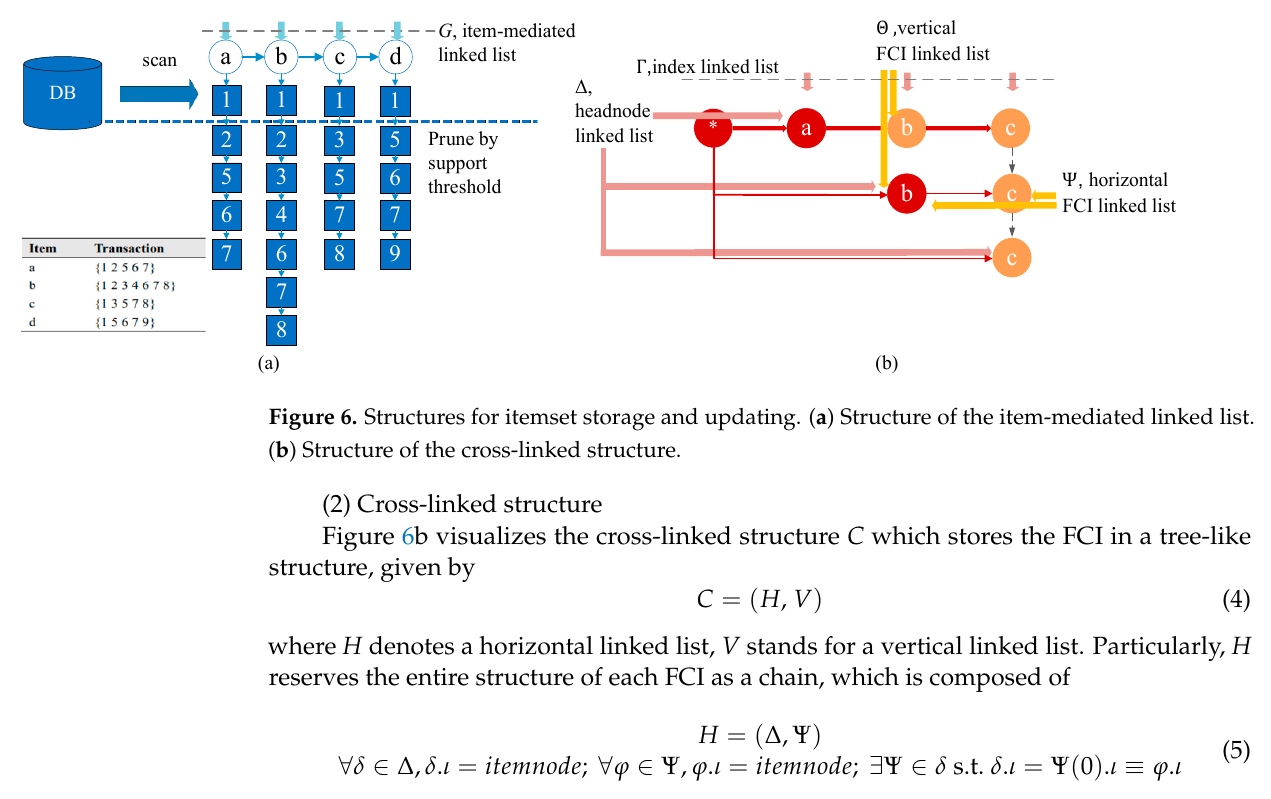
Figure 7. Detailed procedures for the cross-linked structure updating mechanism. (sup: support value, t: transaction set). 3.2. Knowledge Mining Procedure The cross-linked structure updating procedures in the MPAMS organizational knowledge mining process are depicted in Figure 7. First, the database is scanned to con- struct an item-mediated linked list G . Subsequently, the cross-linked structure C grows along with the iteration over graphnodes of G . When a new graphnode is added, the cross- linked structure is updated in five steps: Step 1: Analyze all the attached branches Ψ of each headnode g . In the case of a-head , branches { a-b-c } and { a-c } should be covered, and the longest chain { a-b-c } will be analyzed first.